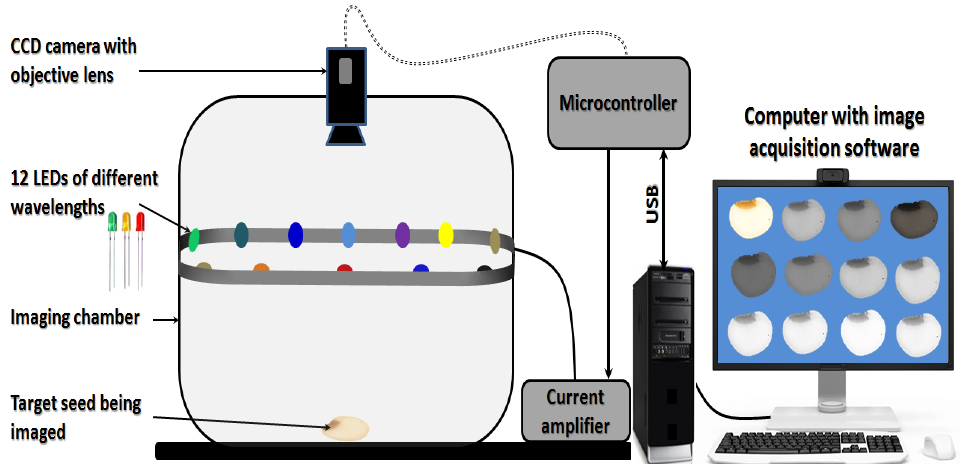
Figure 3. An illumination-based multispectral imaging system supported with an array of 12 LEDs with different nominal emission wavelengths. Each LED is sequentially switched on and synchronized with the camera trigger for image acquisition using a pre-programmed